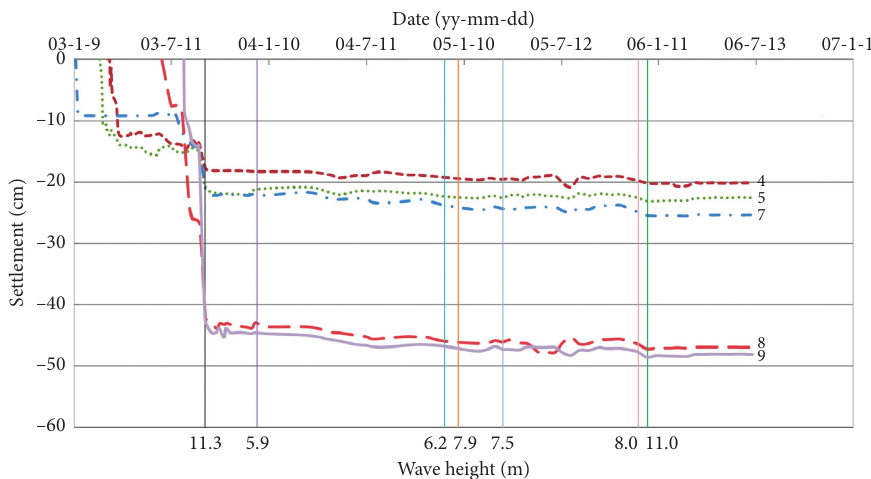
Figure 3: Settlement time history of caissons #4, 5, 7, 8, and 9.